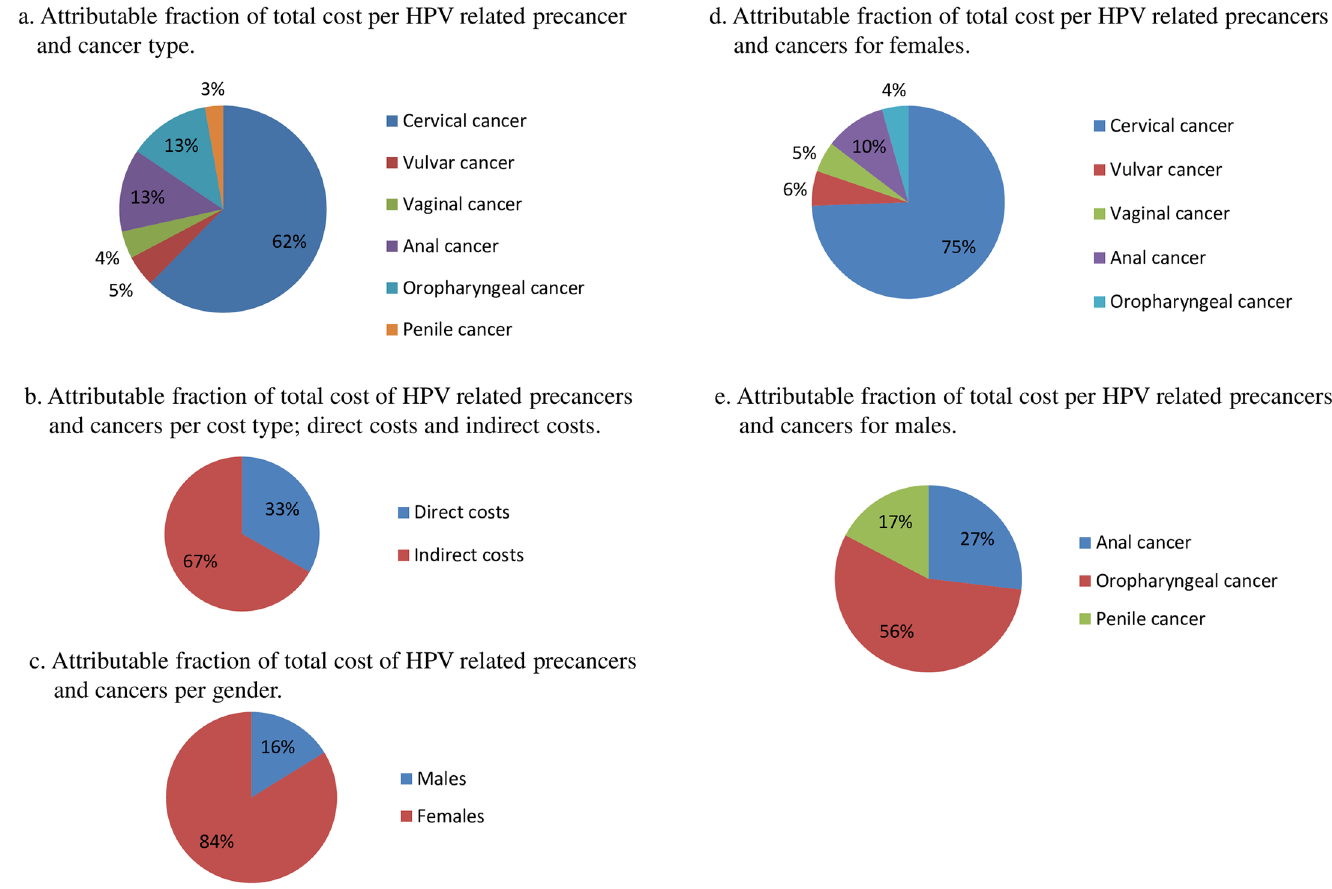
Fig 3. Attributable fraction of total costs including both direct costs (i.e., inpatient care and outpatient care) and indirect costs (i.e., mortality, sick leave, and early retirement days) presented per HPV-relateddisease and gender. (a) Attributablefraction of total cost per HPV related precancer and cancer type. (b) Attributablefraction of total cost of HPV related precancersand cancers per cost type; direct costs and indirect costs. (c) Attributable fraction of total cost of HPV related precancers and cancers per gender. (d) Attributablefraction of total cost per HPV related precancers and cancers for females. (e) Attributablefraction of total cost per HPV related precancers and cancers for